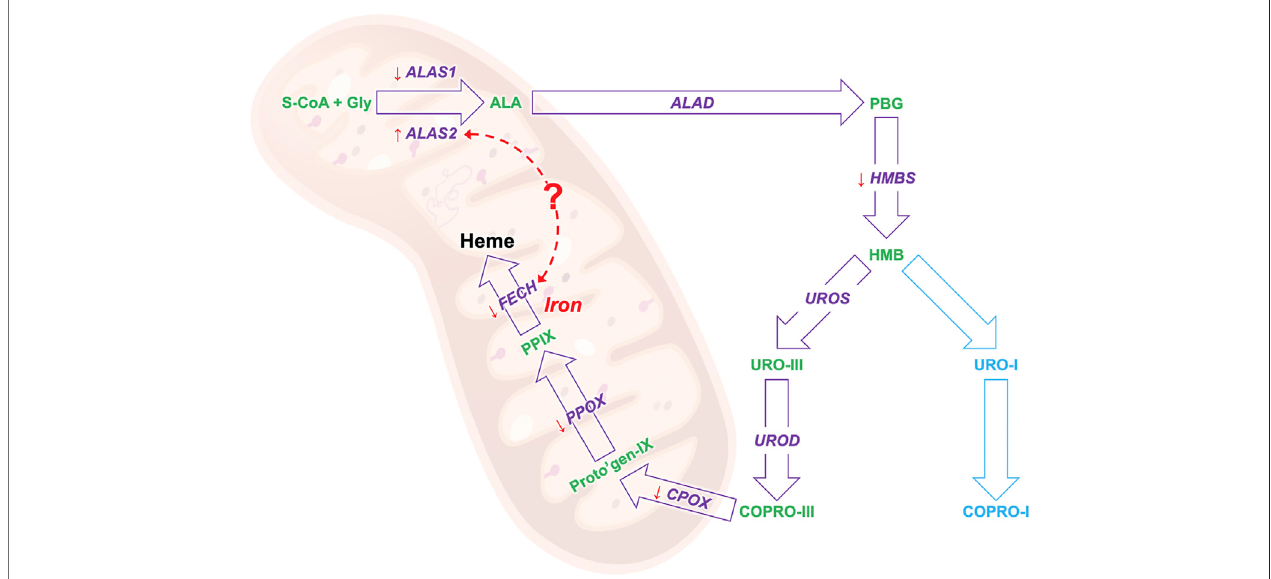
FIGURE 5 | The results of the biosynthesis pathway mRNA study: the gene that encodes for the enzyme in given in purple and the heme precursors are given in greens. The orange arrows show the gene expression trend of EPP patients as compared to healthy controls, an arrow pointing down indicates a lower expression and up a high expression. The red dotted arrow indicates a possible link between the mRNA expression of the ALAS and FECH genes.